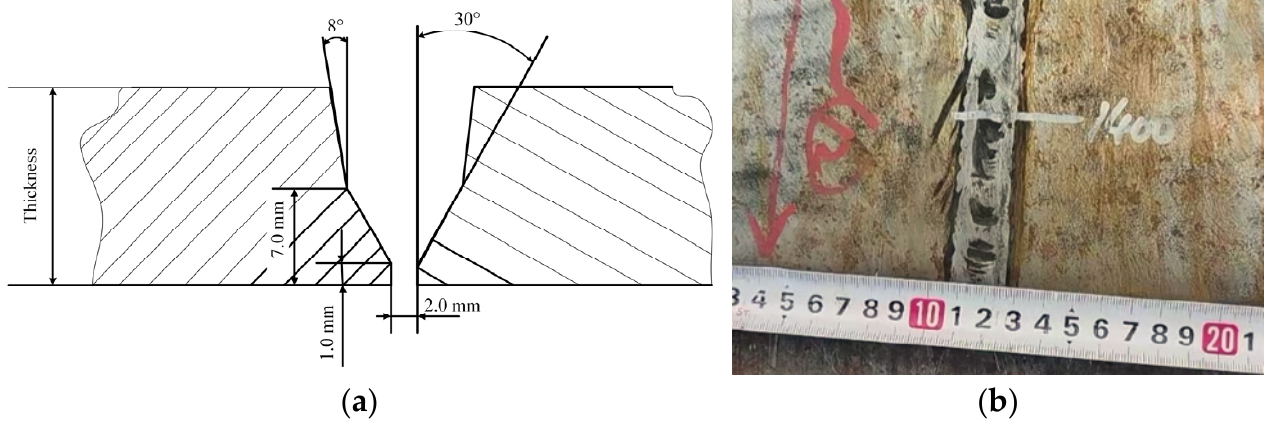
Table 2. Chemical composition of X80 base metal steel (wt%).